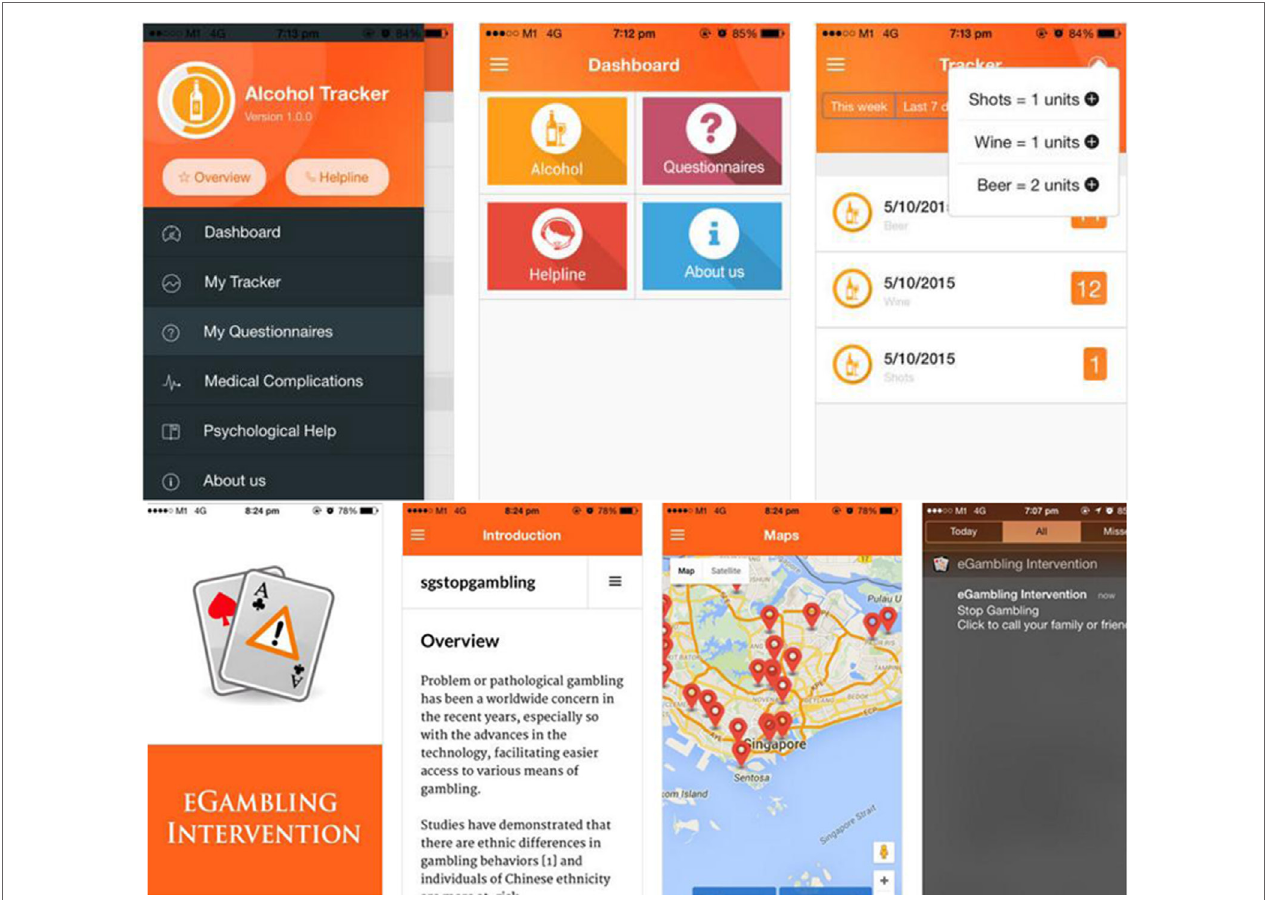
FiGUre 2 | Overview of the conceptualization and features of an alcohol tracker application and a gambling intervention for at-risk individuals